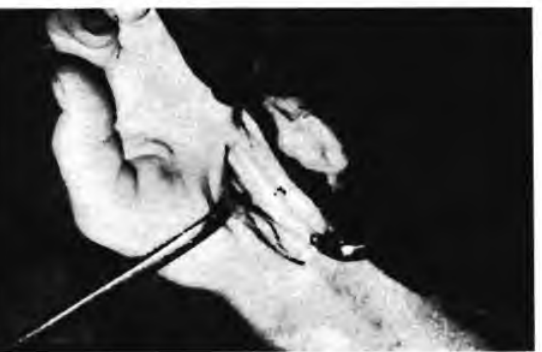
Fig. 7. Synovectomy and decompression of the carpal tunnel.